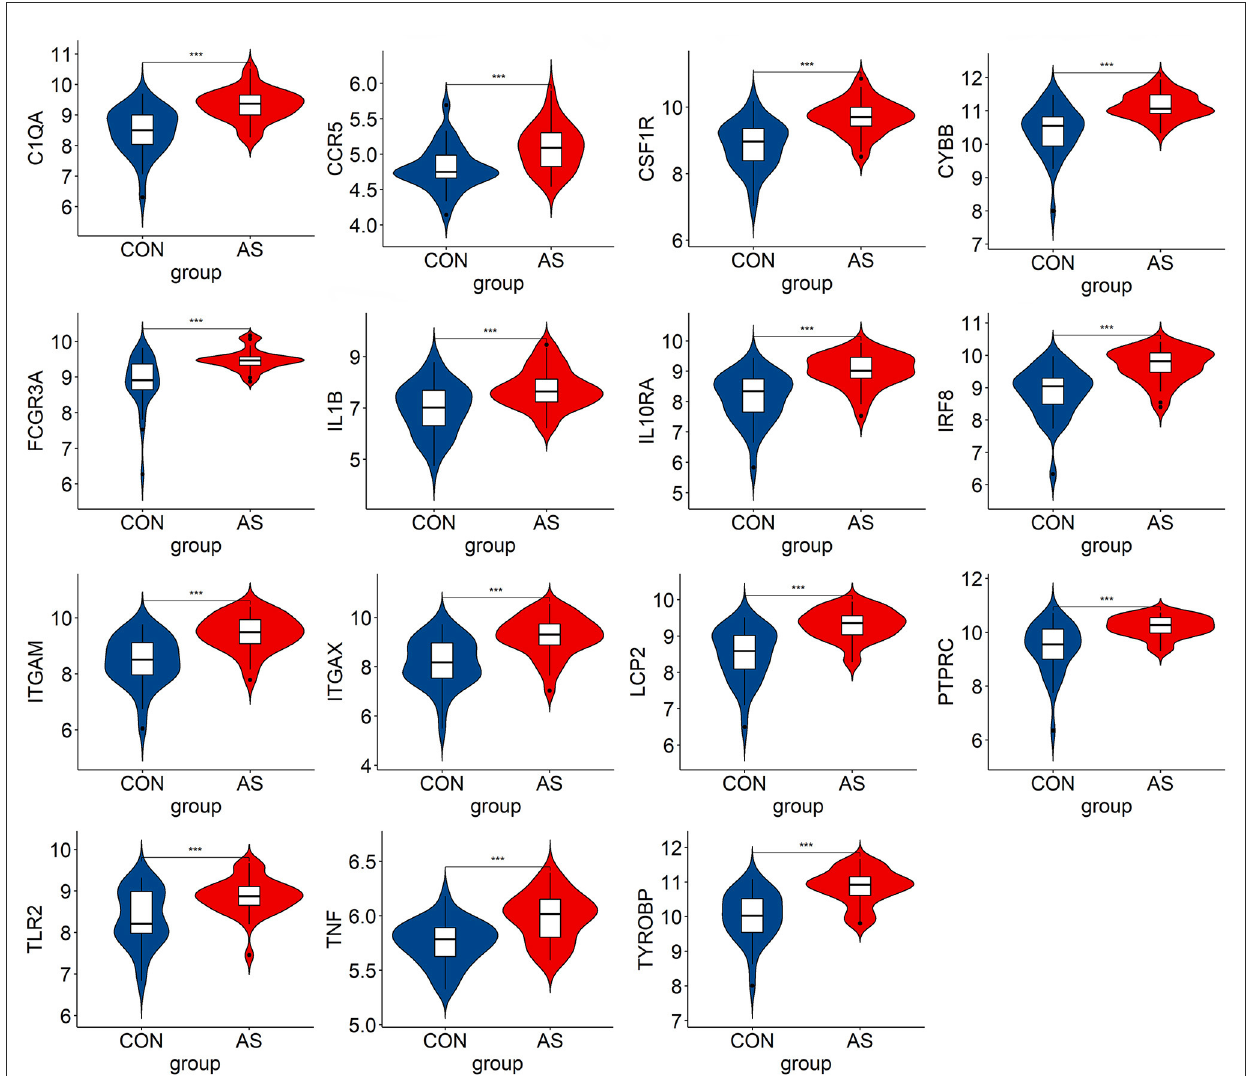
FIGURE6 The hub genes expression level in GSE43292. The mean t -test is used for the comparison of the two datasets. Statistical significance was determined when the P -value < 0.05. AS, atherosclerotic plaque; CON, control artery samples. *** p <